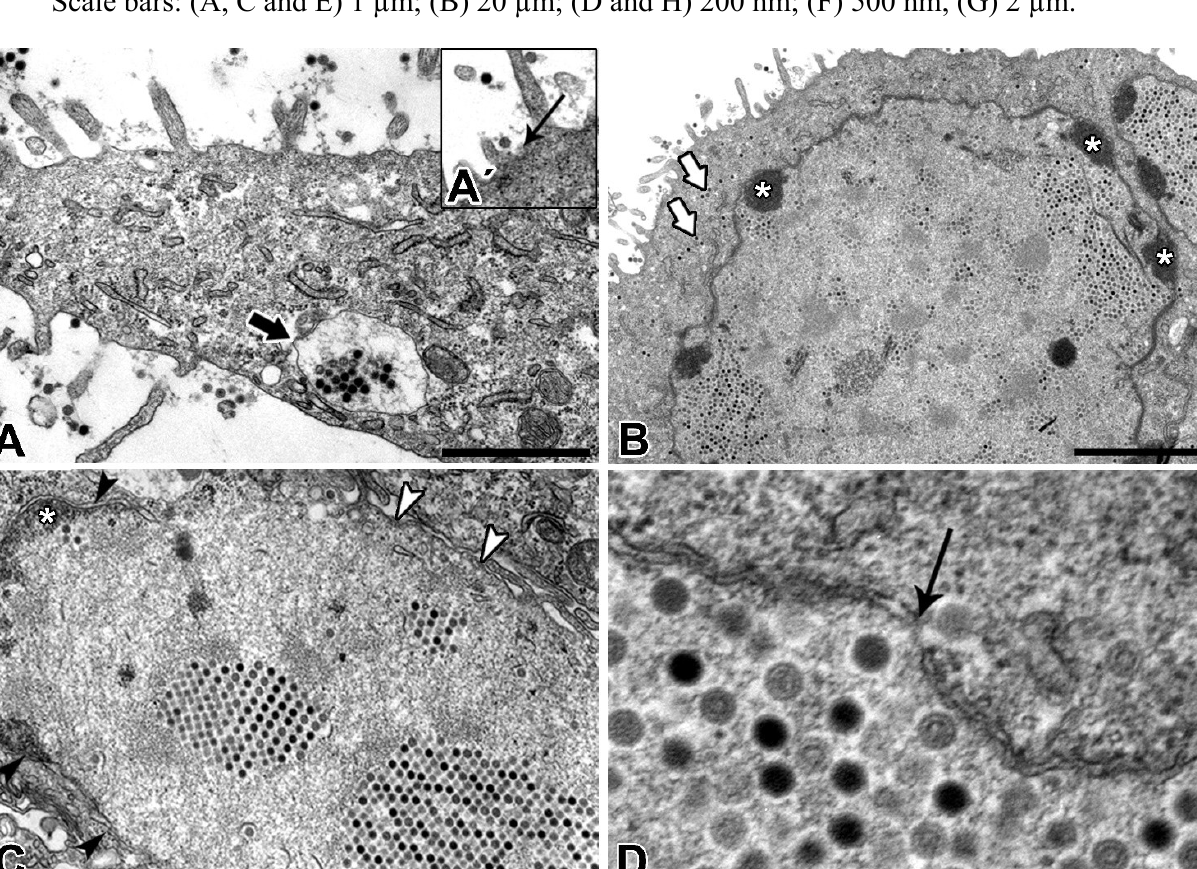
Figure 5. Transmission electron micrographs of PAdV-SVN1 in NPU cells isolated from porcine urinary bladder. PAdVs enter the NPU cells by endocytotic uptake (arrow on A´ ). After the endocytosis, the virions are found in late endosomes ( A ) or sporadically scattered in the cytosol (arrows on B ). After the cell internalization, the virions are found in the nucleus, organized in larger paracrystalline arrays or spread throughout the nucleus in smaller clusters ( B ). Commonly the condensed chromatin at the nuclear envelope of infected NPU cells is noted (asterisks on B and C ). The possible mechanism of nuclear escape includes the separation of nuclear envelope and merger of the nucleus full of virions with the cytosol (black arrowheads on C indicate the nuclear envelope, white ones the plasma membrane), or maybe even the individual release of virions through the nuclear pore (arrow on D ). After re-entry to the cytosol, the virions are found both, in the large paracrystalline arrays ( E ) or randomly distributed throughout the cytosol ( F ), with frequently observed degradation of the cytoplasm at the site of their presence ( F ). At this point, the initiation of NPU cell necrosis can be observed. With the progress of cell lysis, the cell detaches from the epithelium, i.e. , urothelium ( G ); the nucleus disintegrates and condensed chromatin is moved near the plasma membrane (asterisks on G ). At the final stage of necrosis, virions leave the cell through the lysed plasma membrane (arrows on H ). Scale bars: (A, C and E) 1 µm; (B) 20 µm; (D and H) 200 nm; (F) 500 nm, (G) 2